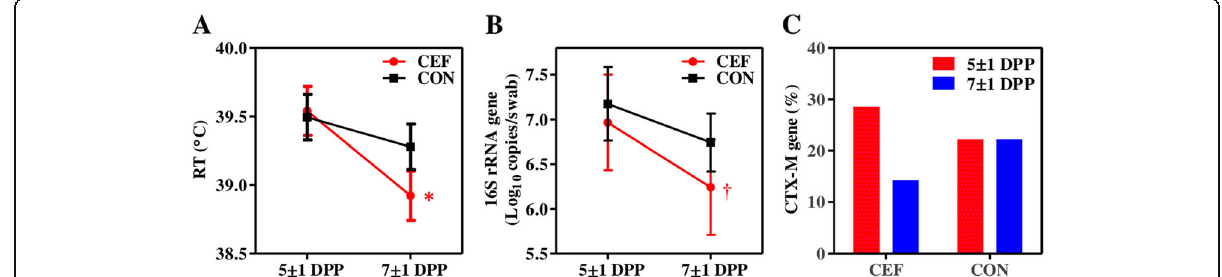
Fig. 7 Ceftiofur effects on rectal temperature (RT), total bacteria, and antibiotic resistance in postpartum cows with metritis. a RT of cows was compared between 5 ± 1 DPP and 7 ± 1 DPP within the group using paired t-test (CEF: P = 0.04 * , CON: P = 0.18). b The number of total bacteria in the uterus was quantified as the log copy number of the 16S rRNA gene per swab. The Wilcoxon signed-rank test was used to compare total bacteria between 5 ± 1 DPP and 7 ± 1 DPP within the group (CEF: P = 0.08 † , CON: P = 0.30). c The percent of animals carrying bla CTX-M gene. Data in a and b are presented by mean ±